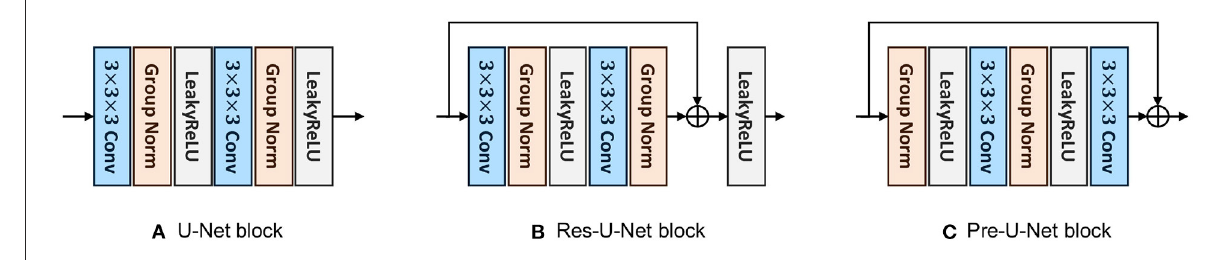
FIGURE3 The proposed blocks. (A) U-Net block. (B) Res-U-Net block. (C) Pre-U-Net